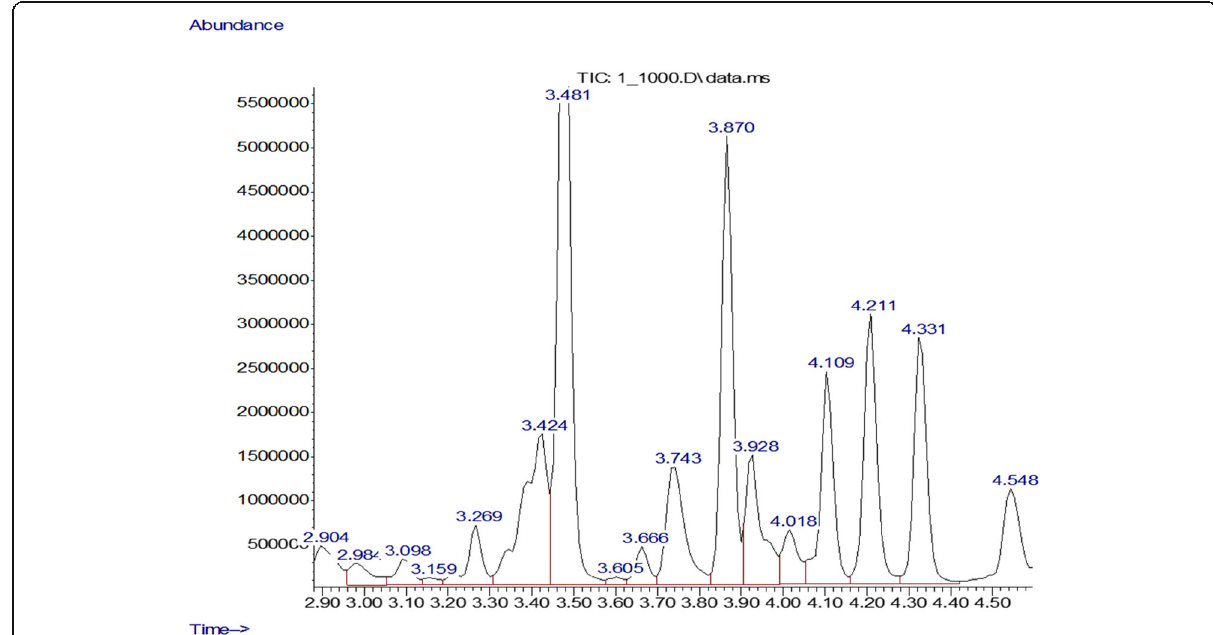
Fig. 1 Total ion chromatogram of Tryptophan 2,4-dimethoxy-5-ethoxyamphetamine (3.74 m/z) in the third instar larvae of L. cuprina